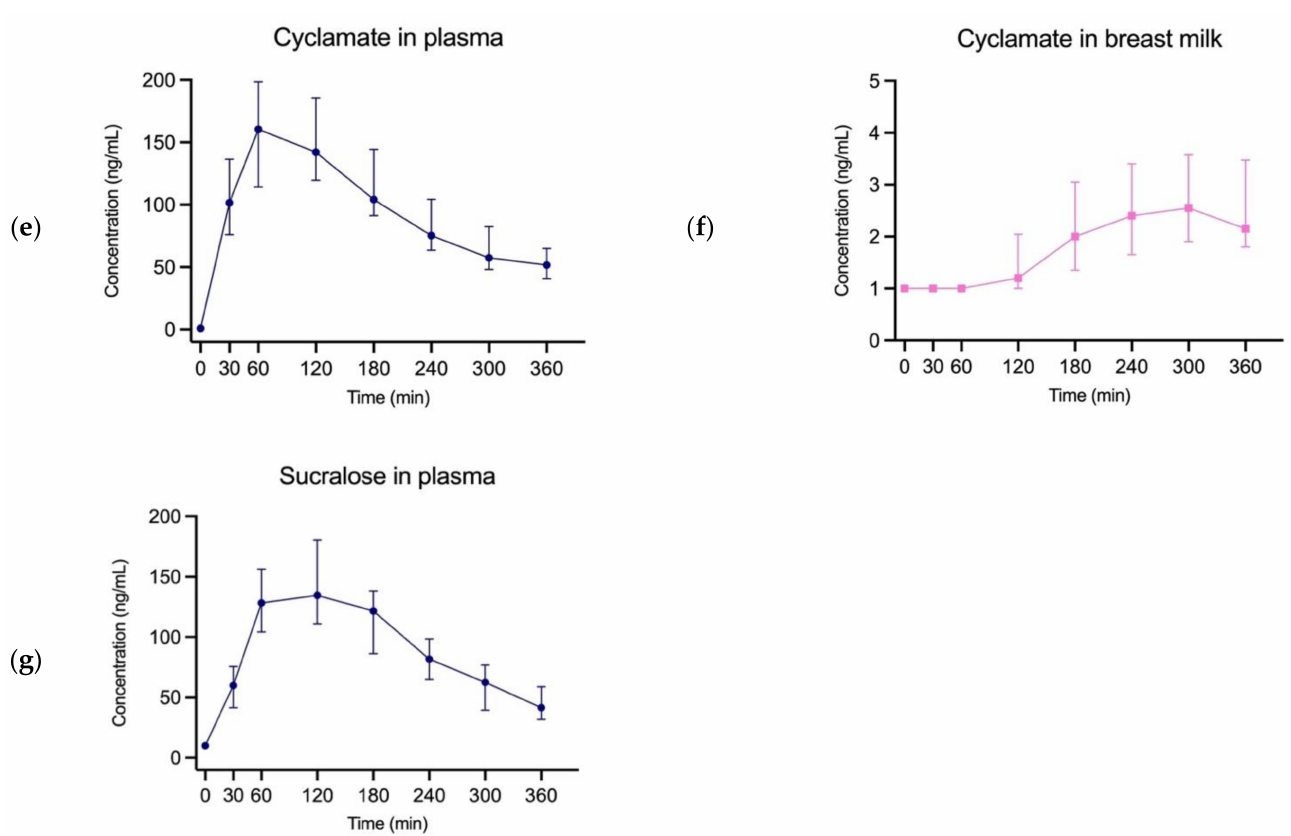
Figure 1. Median concentrations with IQR of sweeteners in plasma (to the left, ( a , c , e , g )) and breast milk (to the right, ( b , d , f )). Concentration of sucralose in breast milk did not reach LOQ and therefore no graph could be created. Outliers have been removed for each sweetener: a + b) n = 46, c + d) n = 46, e + f) n = 44, g) n =